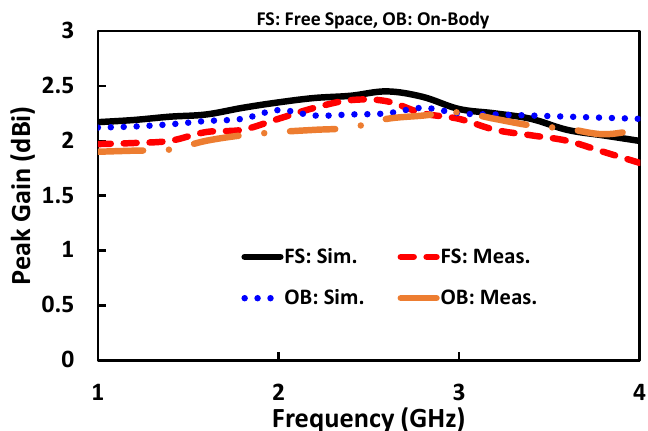
Figure 12. Simulated and measured peak gain of the antenna.